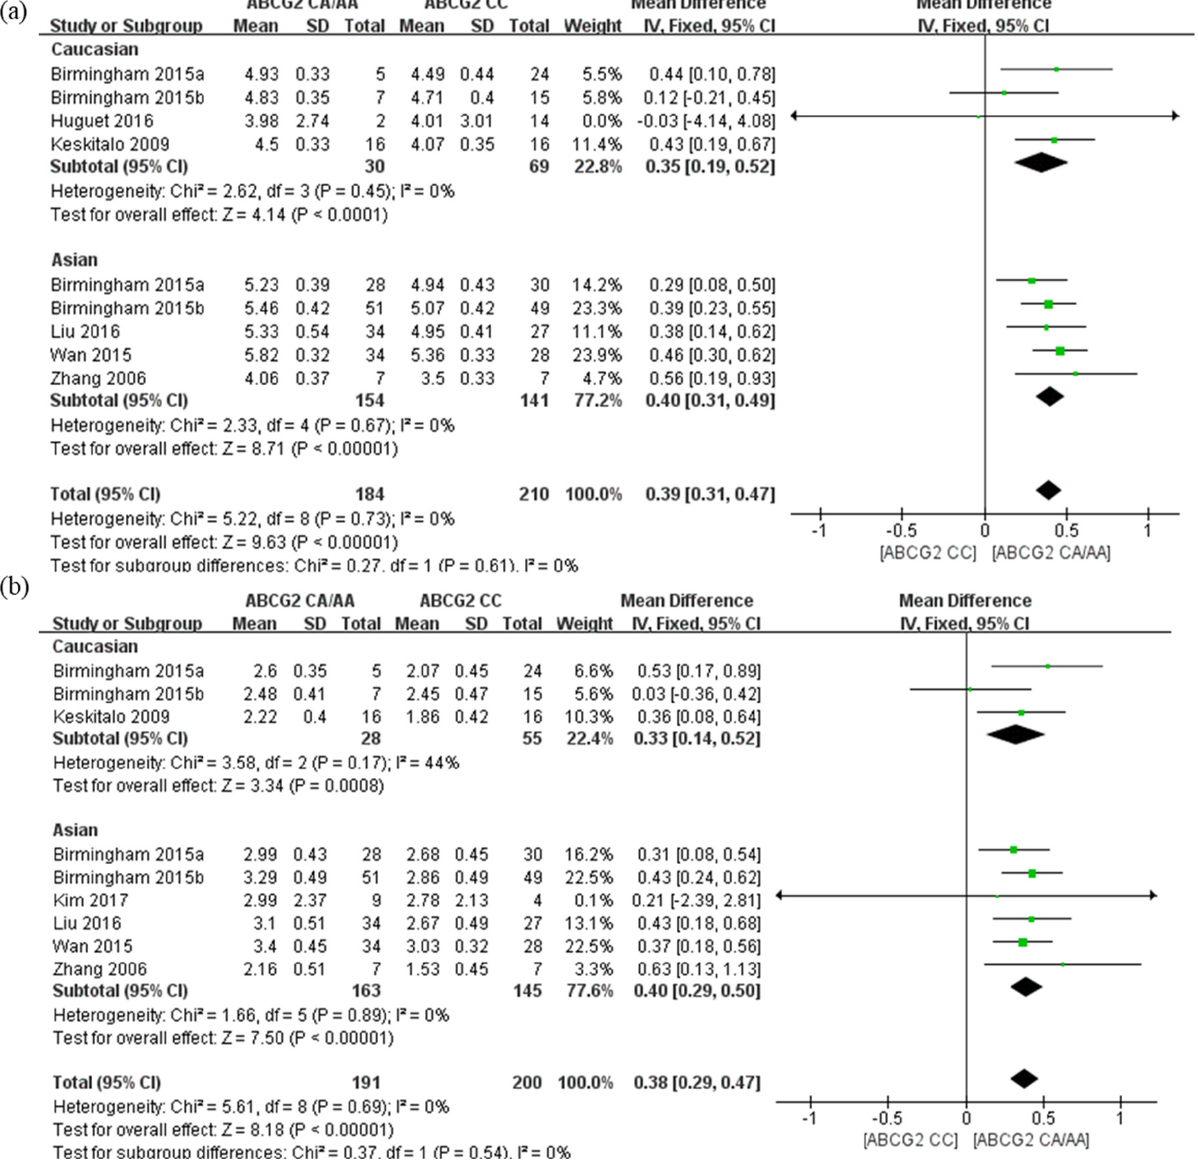
Figure 3. Forest plots of the effects of ABCG2 421C>A on rosuvastatin; values expressed as logarithm of geometric mean ( a ) AUC 0- ∞ and ( b ) C max in healthy Caucasian and healthy Asian subjects. The effect size for each individual study is represented by the green square and the overall pooled effect size is represented by the black diamond.